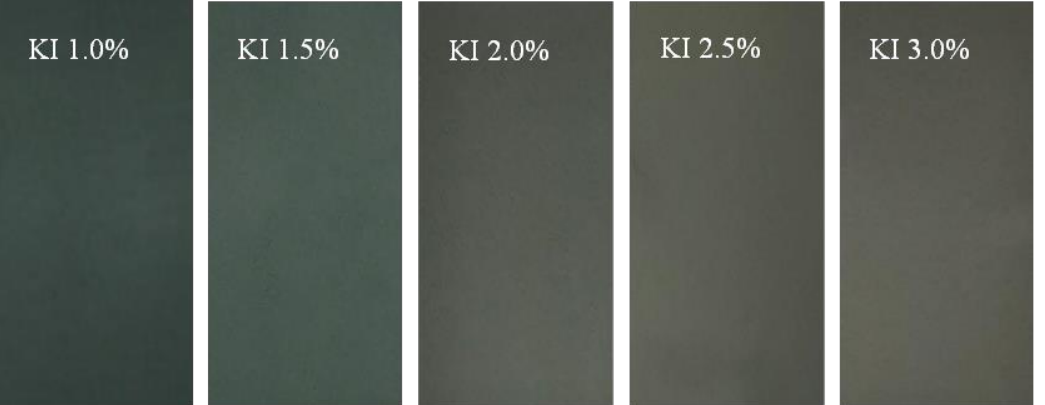
Figure 2. The comparison of PVA polarizing films which were stretched 6 times prepared in the correcting tank with the concentration of KI from left to right being set to 1.0%, 1.5%, 2.0%, 2.5% and 3.0%, respectively.